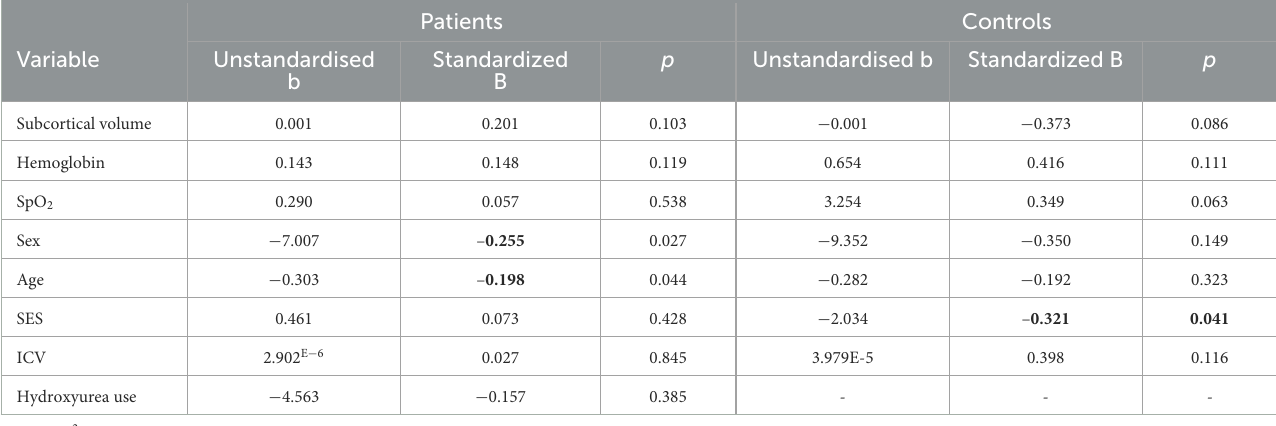
TABLE 5 Regression coefficients for working memory index in